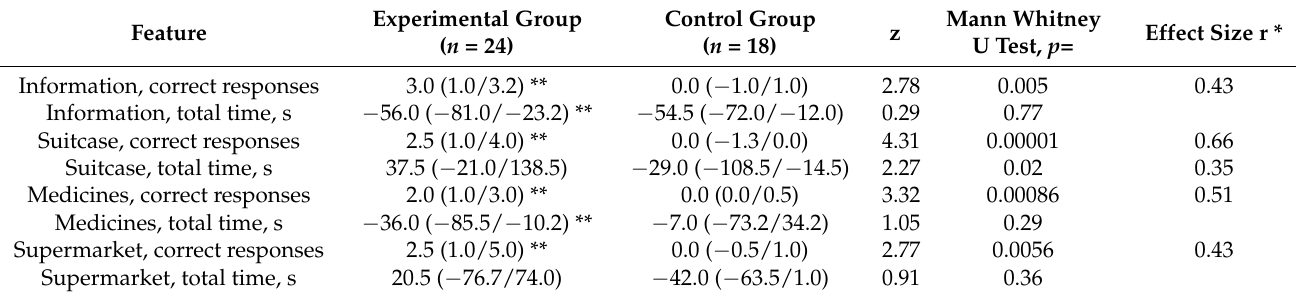
Table 2. Differences between the second (T3) and the first (T1) in vivo test in the experimental and control group, and results of the comparisons between the two groups.